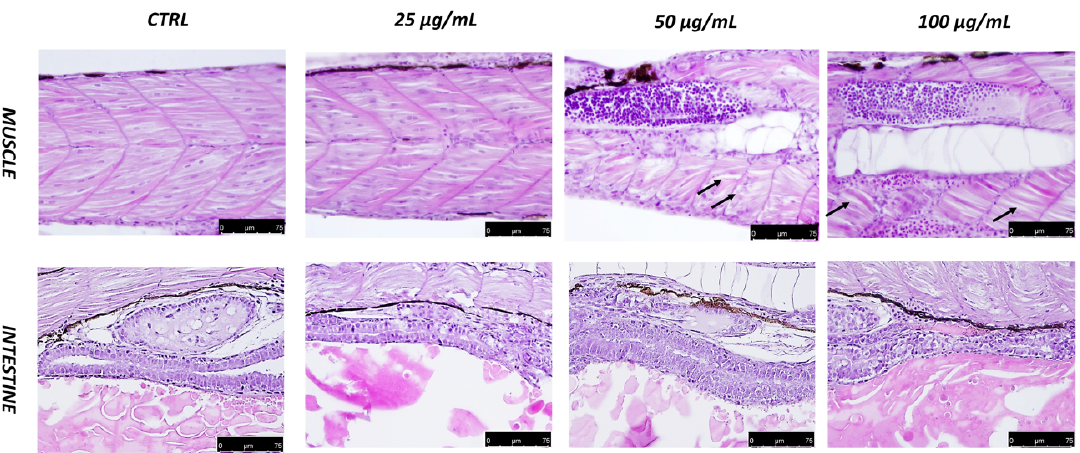
Figure 3. Histopathological changes in the intestines and muscles of zebrafish larvae exposed to fotemustine at 96 hpf. Muscle atrophy is indicated by a dotted black arrow (40 ×